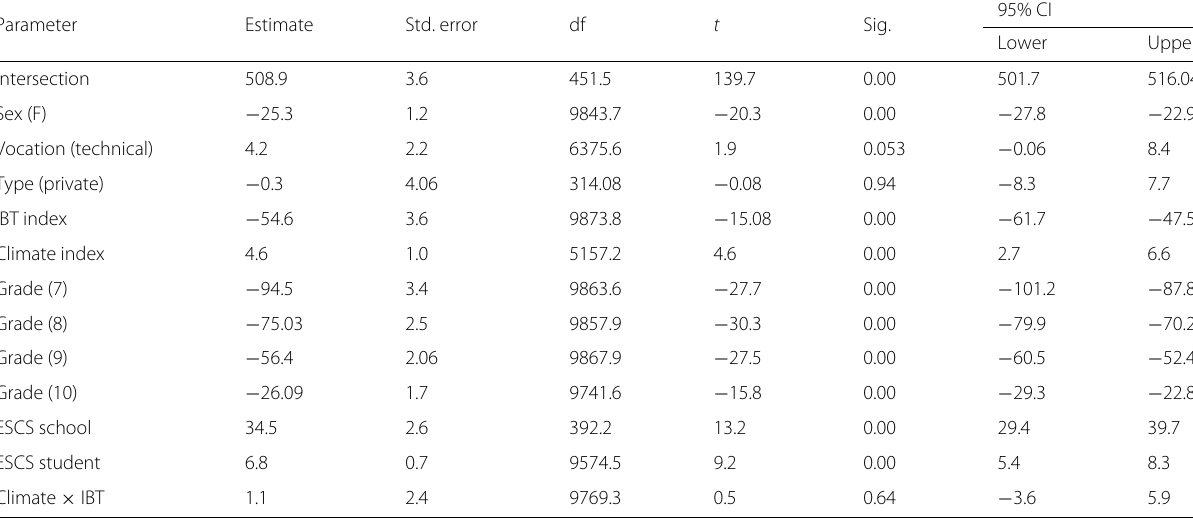
Table 2 Hierarchical linear regression with science performance as the dependent variable Parameter